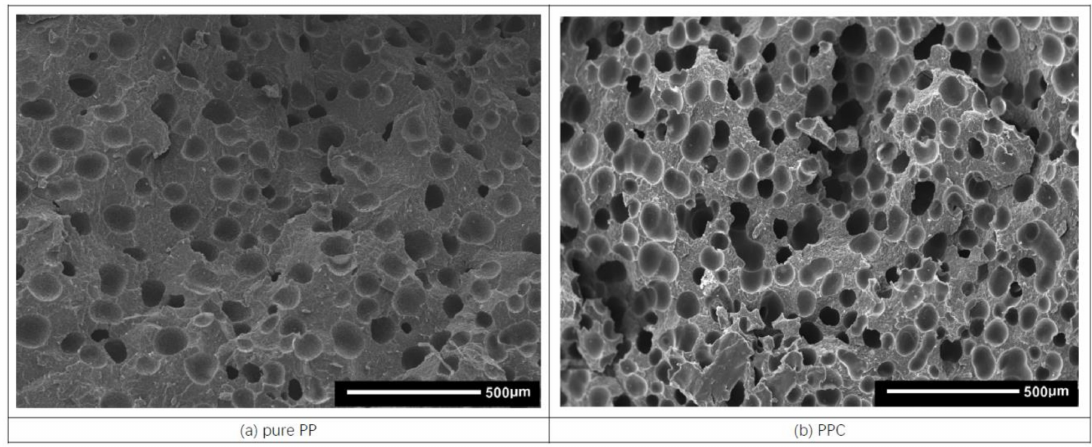
Figure 5. SEM images of the six selective foamed PP/PC samples. ( a : pure PP; b : PPC; c : PCM; d : PCG; e : PCE; f : pure